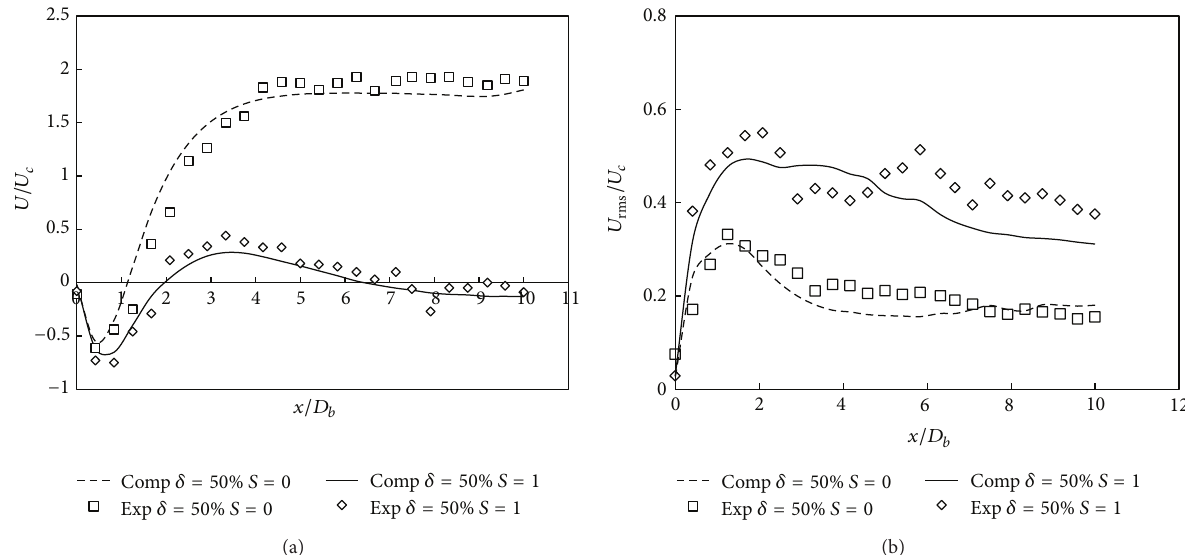
Figure 4: Comparisons between simulated and measured time-mean streamwise velocity (a) and turbulence intensity (b) distributions along the near wake of the disk burner.